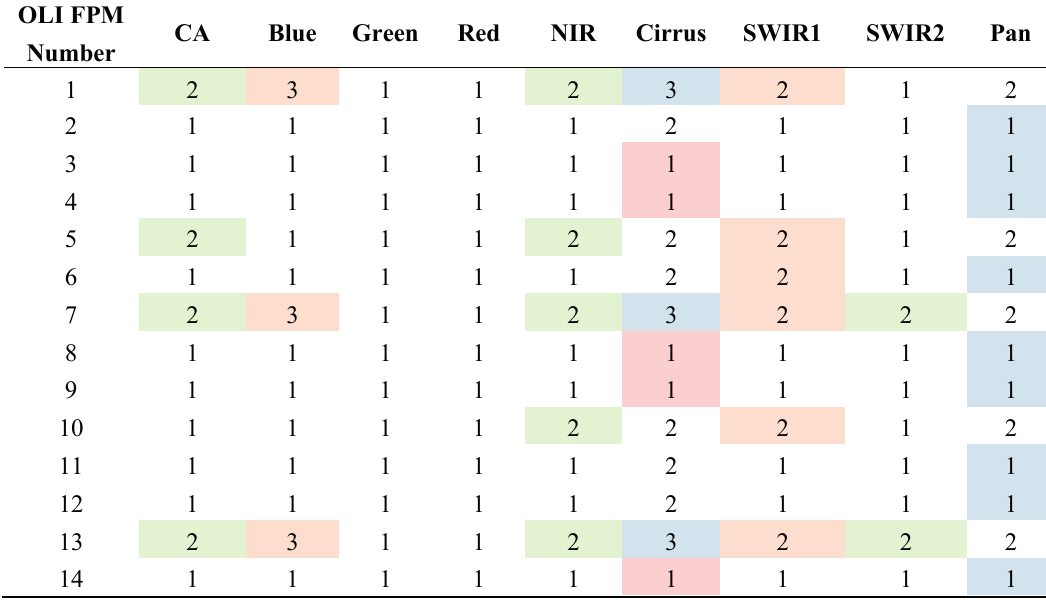
Table 2. Filter wafer distribution across the OLI focal plane. Numbers indicate which wafer was the source of the filter applied to each module (colors are to aid in visibility).